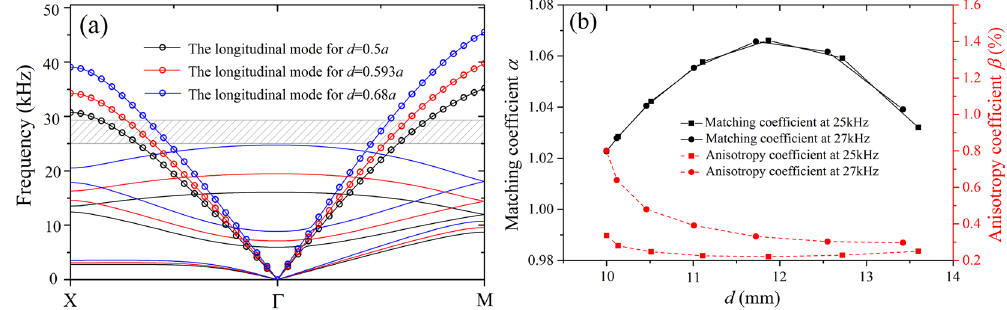
Figure 2. ( a ) The band structures for three different values d = 0.5 a , 0.593 a and 0.68 a ; and ( b ) the variations of the coefficients α and β with d at the self-focusing frequencies of 25 kHz and 27